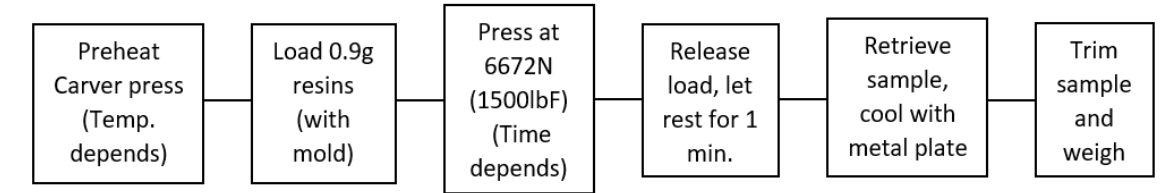
Figure 13. Flow chart showing the protocol for MLR determination.